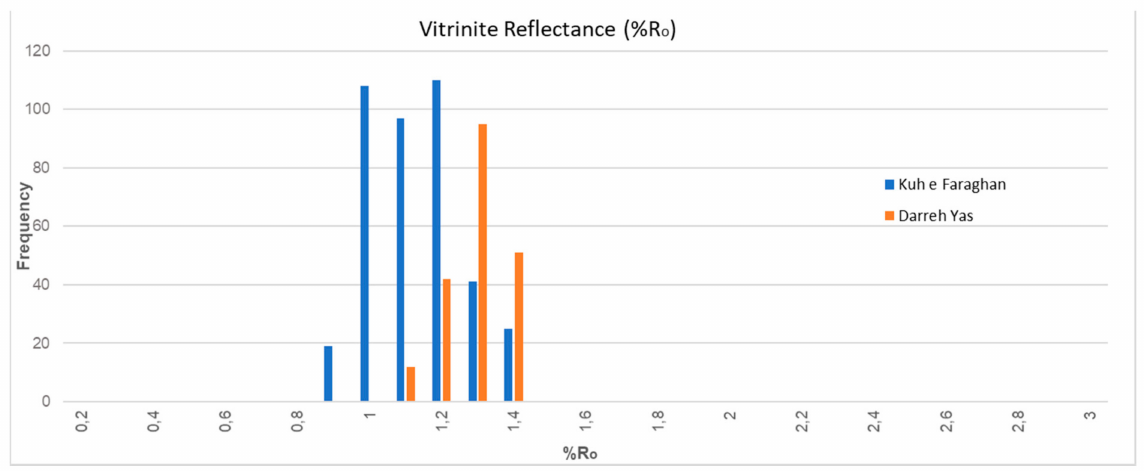
Figure 5. ( a ) Relationship between HI and T max plotted in the diagram of Espitali é et al. [140]; ( b ) Cross-plot of the relationship between TOC vs. PY; ( c ) Cross-plot of the relationship between the pyrolysis T max vs. PI; ( d ) Cross-plot of the relationship between the pyrolysis TOC vs. S 1 of the Faraghan Formation at the Darreh Yas and Kuh e Faraghan sections.